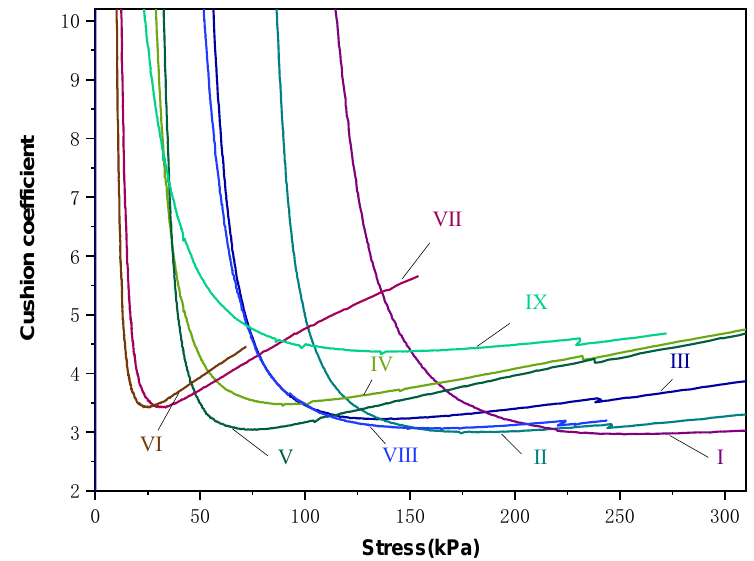
Figure 13. Cushion coefficient of materials with different water contents.